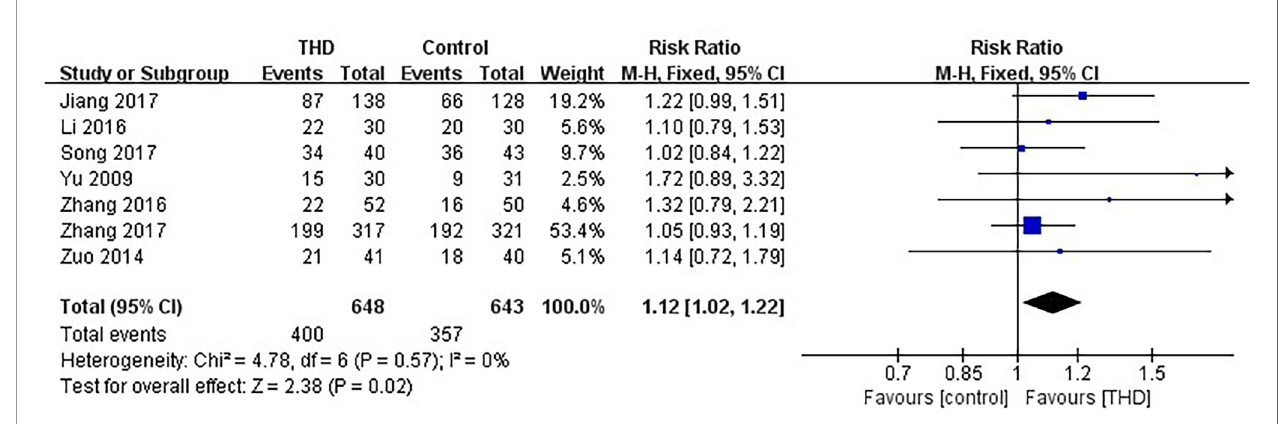
FIGURE 6 | Meta-analysis on no nausea (acute phase).